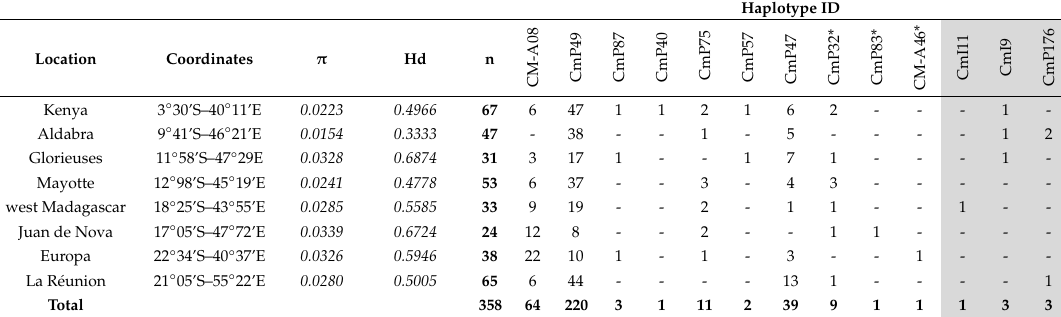
* Haplotypes found only at rookeries outside the SWIO; CmP32 (Micronesia), CmP83 (Western Australia), CM-A46 (Acension Island).